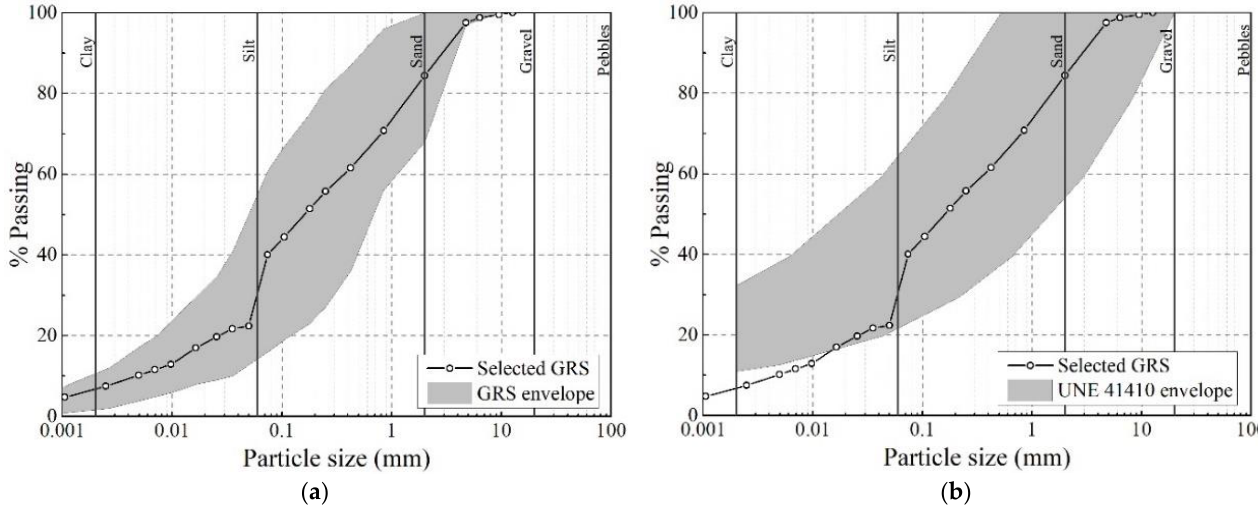
Figure 3. PSD of the selected soil and comparison with the envelope of ( a ) GRSs from Northern Portugal, according to Viana da Fonseca [37] and ( b ) soils recommended for CEBs production, according to UNE 41410 [39].